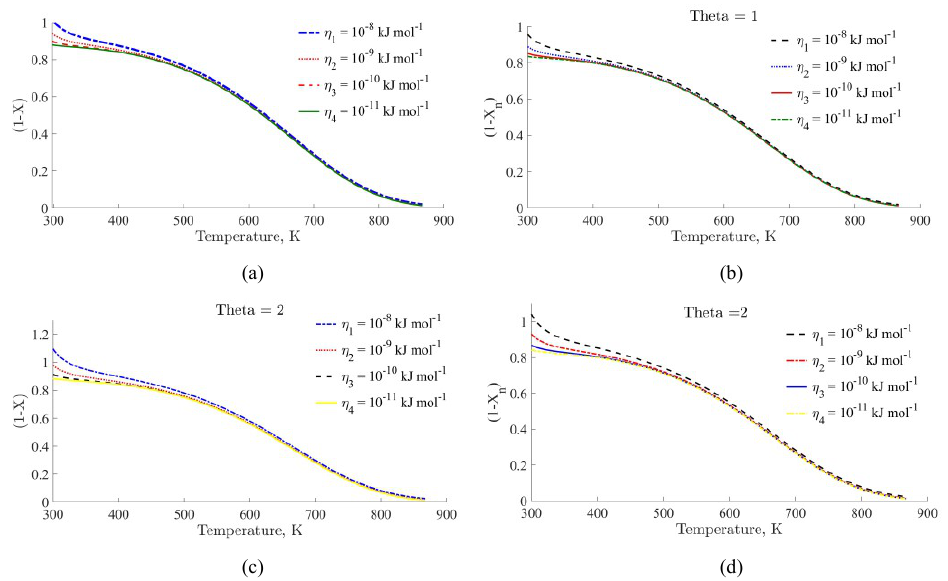
Fig. 3. The effect of scale parameter ( η (kJ mol −1 )) of the Weibull distribution on the numerical results of bi-variant scheme for DAEM: (a) first order reaction ( θ = 1); (b) n th order reaction ( θ = 1); (c) first order reaction ( θ = 2); (d) n th order reaction ( θ = 2) ( A = 1.5·10 −005 s −1 , β = 0.0920, m = 10 °C min −1 and n =